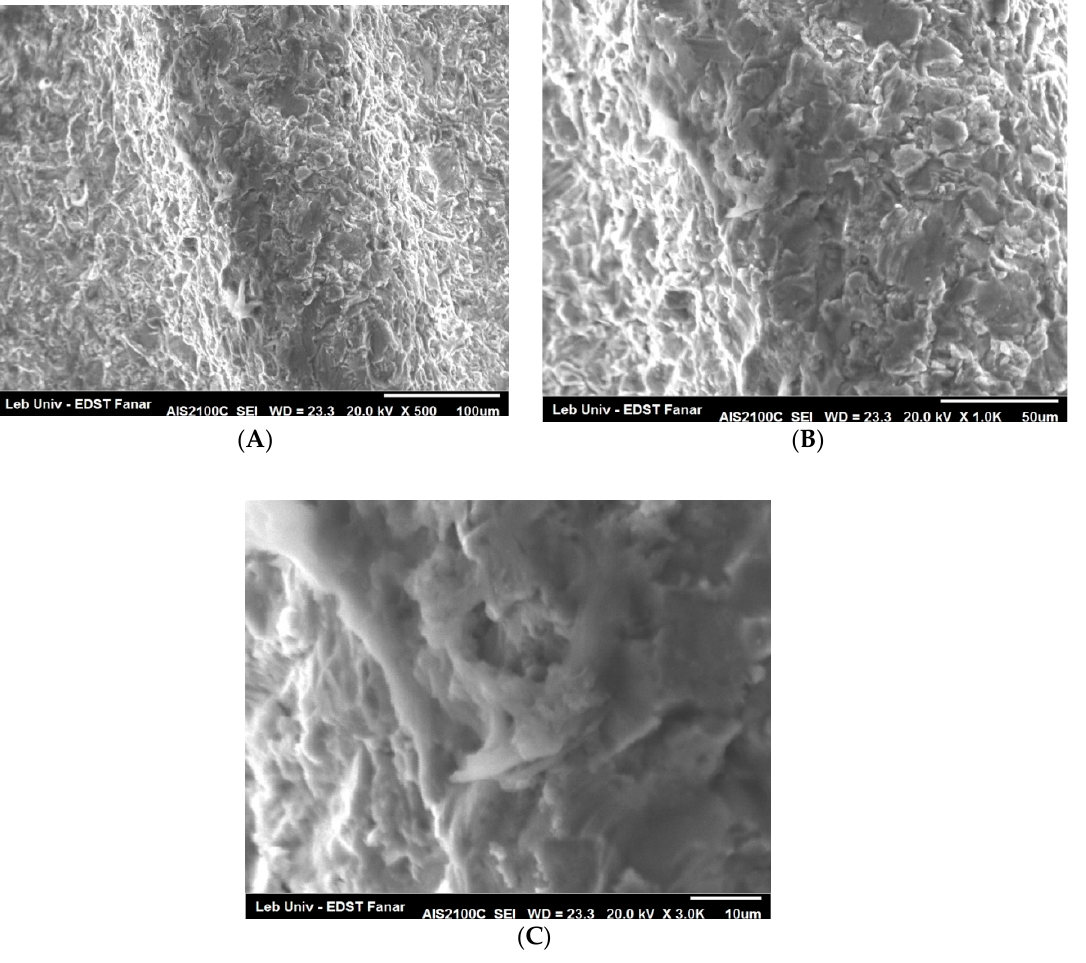
Figure 8. The implant surface irradiated by the Er:YAG laser, under 50 mJ/pulse, for three passages, at the magnification ( A ) ( × 500), ( B ) ( × 1000), and ( C ) ( × 3000).The implant surface did not get affected and the rough surface was similar to the one of the sterile implant.